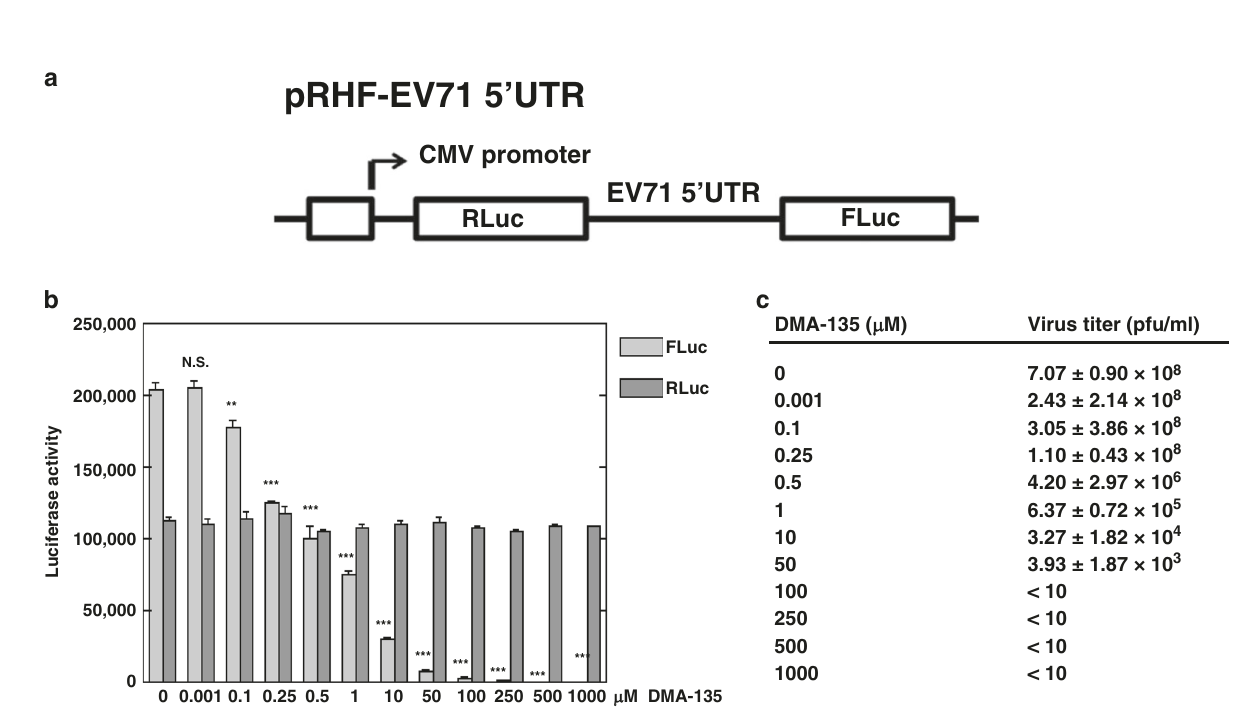
Fig. 2 DMAs bind to the EV71 SLII bulge via an entropically driven mechanism. a Single-point 1 H- 13 C TROSY HSQC titrations of A( 13 C)-selectively labeled SLII constructs with the respective DMAs added at fi vefold excess. The blue correlation peaks across each spectrum correspond to that of free SLII. The spectra were collected at 900 MHz in 10 m M K 2 HPO 4 , 20 m M KCl, 0.5 m M EDTA, and 4 m M BME (pH 6.5) D 2 O buffer at 298 K. b Calorimetric titrations of DMA-001, DMA-135, and DMA-155 reveal a single transition on the binding isotherm characterized by an entropically favored and enthalpically disfavored molecular recognition event. All titration data were processed and analyzed using Af fi nimeter 25 . The processed thermograms were fi t to a 1:1 stoichiometric binding model, represented by the red lines. Reported values for dissociation constants ( K D ) and corresponding standard deviation are from triplicate experiments. Goodness of fi t ( χ 2 ) of the experimental data to the 1:1 binding model are reported for each titration. The experiments were performed in 10 m M K 2 HPO 4 , 20 m M KCl, 0.5 m M EDTA, and 4 m M DTT (pH 6.5) buffer at 298 K. Data represented as mean ±SD of n = 3 experimental replicates. Uncertainties in individual binding isotherms are automatically calculated using Af fi nimeter and are determined by considering the noise and quality of raw data and the dispersion of the integrated signal as a function of concentration.